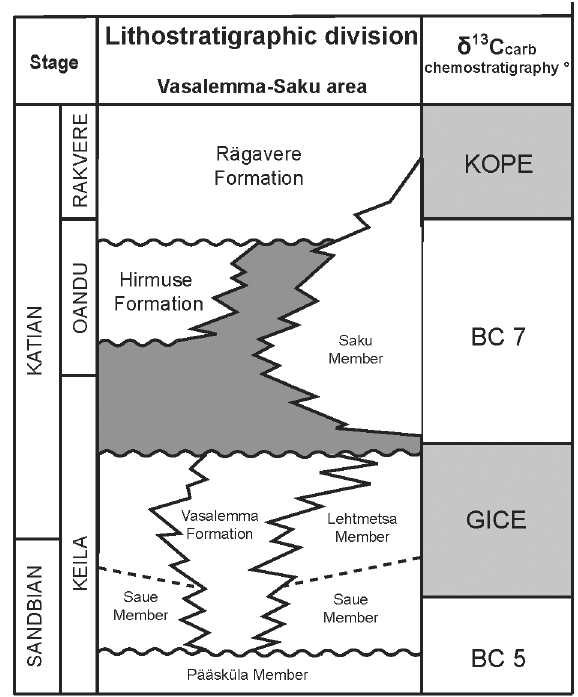
Fig. 2. Lithostratigraphy of the upper Sandbian(cid:150)lower Katian interval in the Vasalemma(cid:150)Saku region, NW Estonia. Dark grey, hiatus; light grey, positive δ 13 C isotope excursion, ”after Ainsaar et al. (2010), Kope = Rakvere